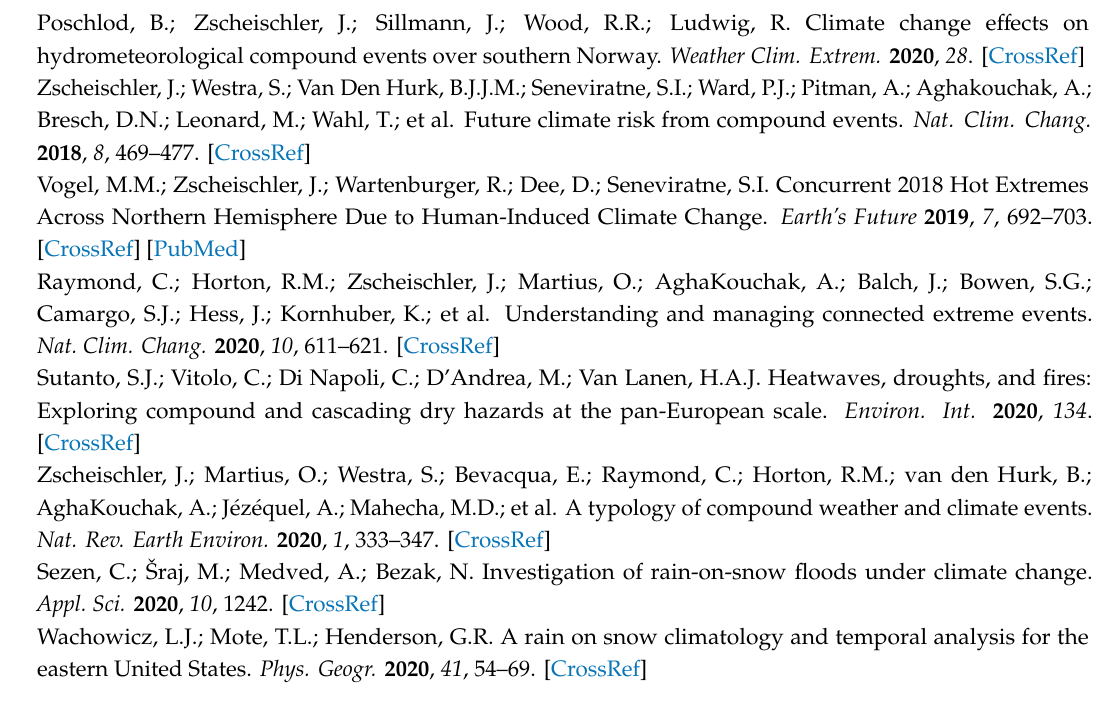
Figure S1: Maximum number of days with compound occurrence of drought and extreme heat according to the basic case and 365 days used as the antecedent precipitation (N), Figure S2: Number of years with at least one compound occurrence of drought and extreme heat according to the basic case and 365 days used as the antecedent precipitation (N), Figure S3: Annual precipitation trend per decade [mm] for the investigated period 1961–2018, Figure S4: Air temperature trend per decade (K) for the investigated period 1961–2018, Figure S5: Mann–Kendall trend test results using mean annual number of days with compound occurrence of drought and extreme heat in the 1961–2018 period. Results for the mild case and N = 365 days are presented, Figure S6: Mann–Kendall trend test results using mean annual number of days with compound occurrence of drought and extreme heat in the 1961–2018 period. Results for the extreme case and N = 365 days are presented, Figure S7: Mean annual number of days with compound occurrence of drought and extreme heat according to the extreme case and 365 days used as the antecedent